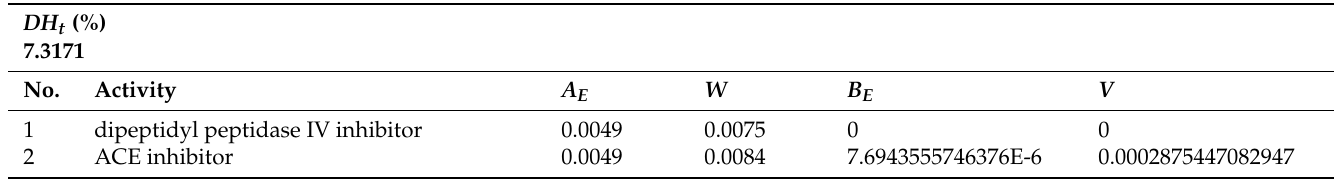
Table A14. A E , DH t , W , B E and V values from RubisCO of Halophila stipulacea . In silico enzymatic cleavage was carried out by V-protease.